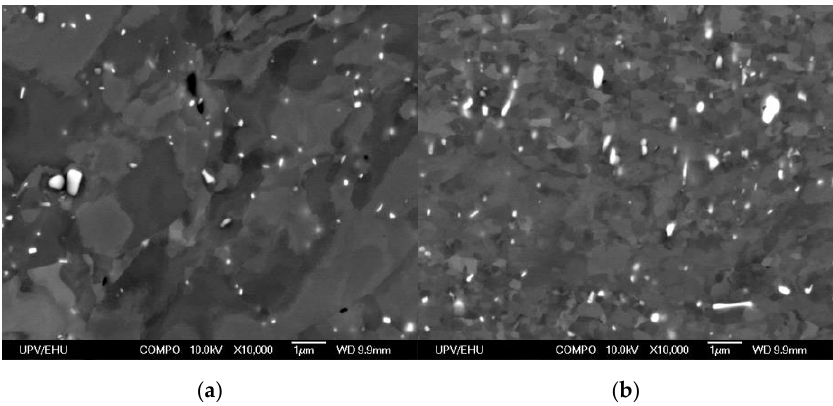
Figure 1. SEM micrographs of different isothermally-forged AA5083 states: ( a ) AA5083 at N0 (annealed); ( b ) AA5083 at N2 (ECAP-processed). Taken from the research work by León et al. [20].